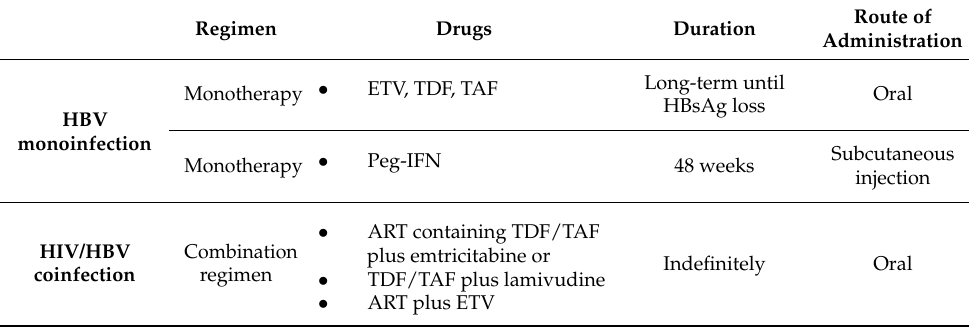
Table 1. Treatment of HBV in patients with and without HIV